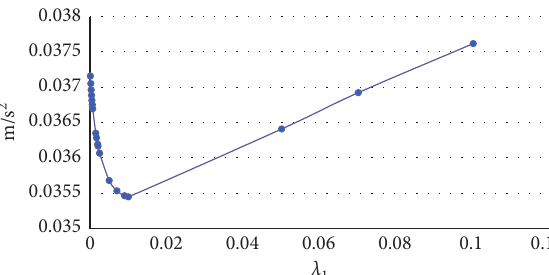
Figure 10: Graph for finding the ridge optimal hyperparameters of the 8 th